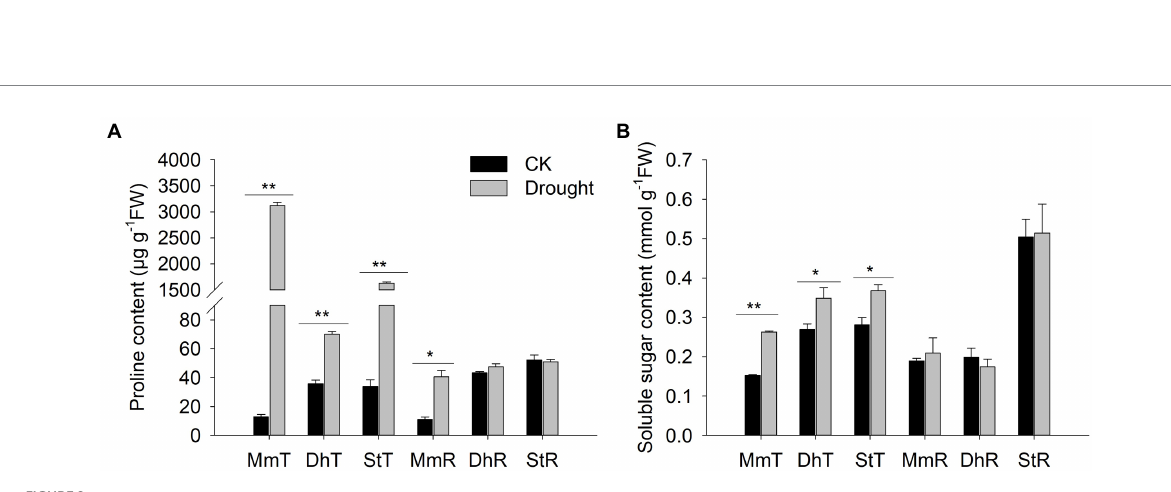
FIGURE 9 Changes of (A) proline and (B) soluble sugar content of two replacement forage legumes and M. micrantha under drought stress and rehydration (average ± SE, n = 3). Different letters above bar plots indicate significant differences analyzed using ANOVA followed by Dunnett’s test. Significance levels: ** p < 0.01; * p <